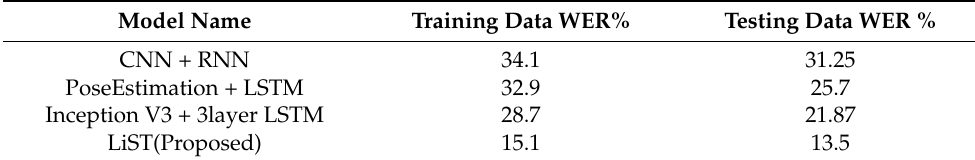
Table 5. WER comparison of different sign language translators using the INCLUDE dataset.